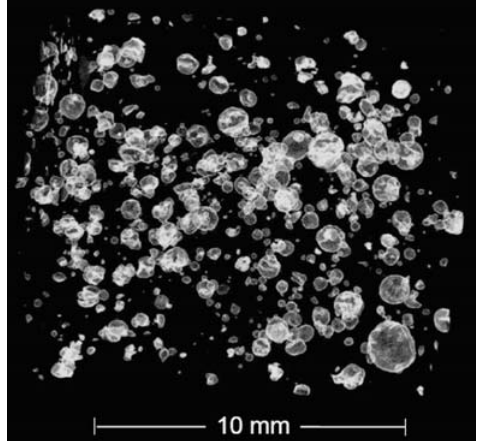
Figure 5. CT image of SAP void distribution in hardened cement